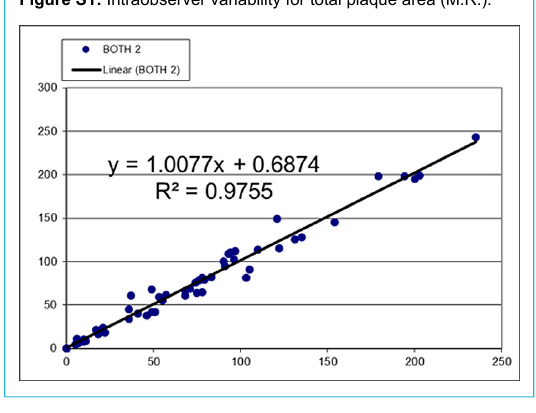
Figure S1: Intraobserver variability for total plaque area (M.R.).